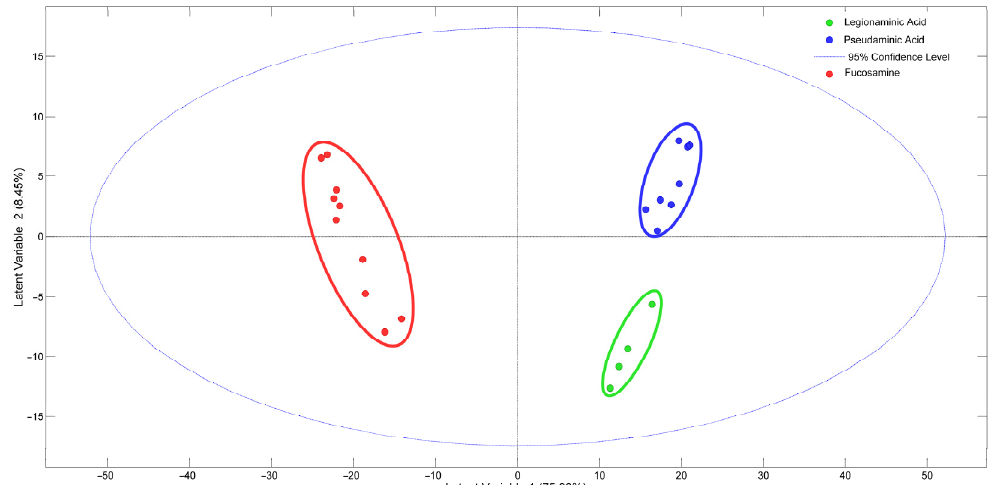
Figure 4. Discrimination of A. baumannii clones by SERS. Score plot of the PLSDA classification model with the first two latent variables (LVs) showing the differentiation of Raman spectra according to the capsule composition (fucosamine, legionaminic acid, pseudaminic acid).